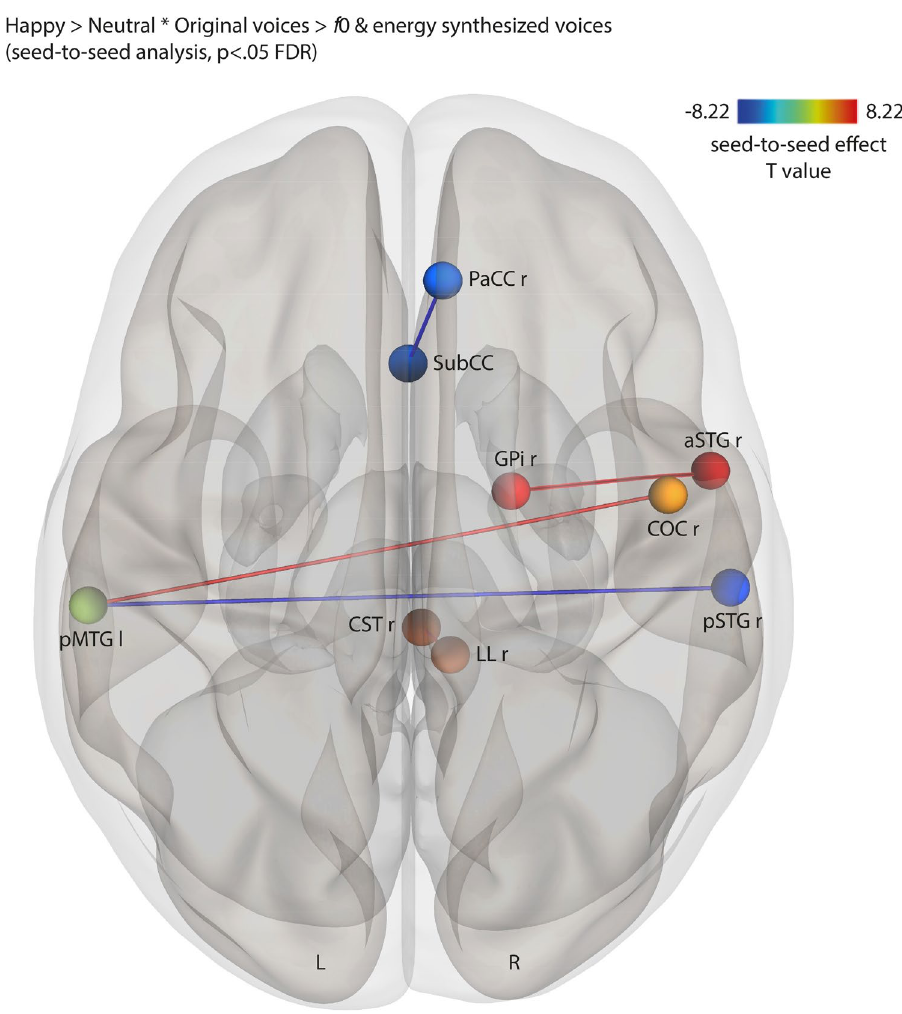
Figure 4. Coupled and anti-coupled seed-to-seed, gPPI functional connectivity for the interaction between the Emotion and the Acoustic parameter factors contrasting happy > neutral voices * original > f 0 & energy synthesized voices, corrected for multiple comparisons ( p < .05 FDR). l and L: left; r and R: right; PaCC: paracingulate cortex; SubCC: subcalcarine cortex; GPi: internal globus pallidus; COC: central operculum cortex; aSTG: anterior superior temporal gyrus; pSTG: posterior superior temporal gyrus; pMTG: posterior middle temporal gyrus; CST: corticospinal tract of the brainstem; LL: lateral lemniscus of the